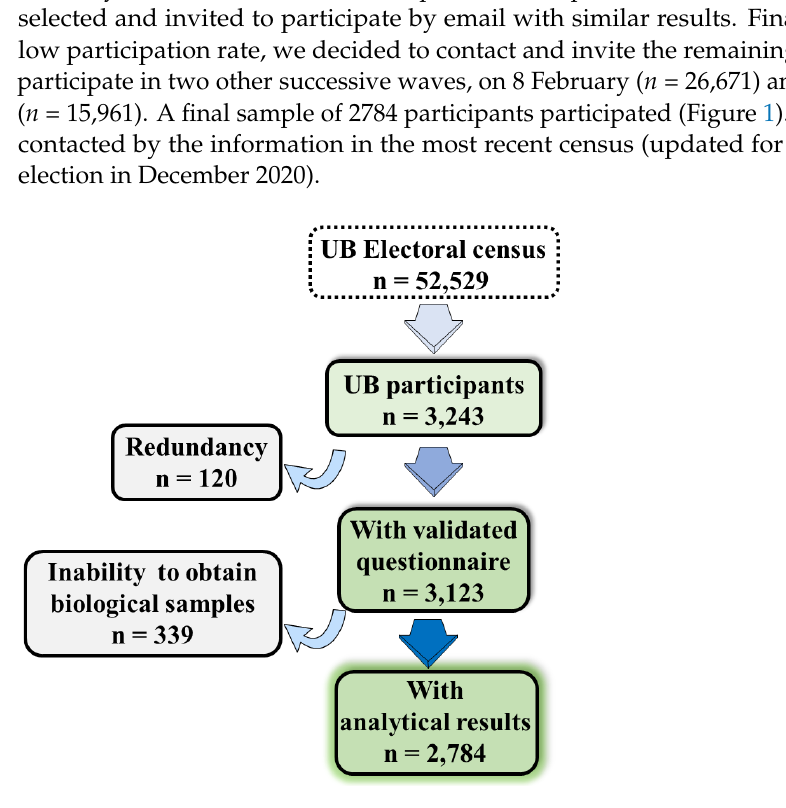
Figure 1. Overview of the flow chart of UB members involved in the study.